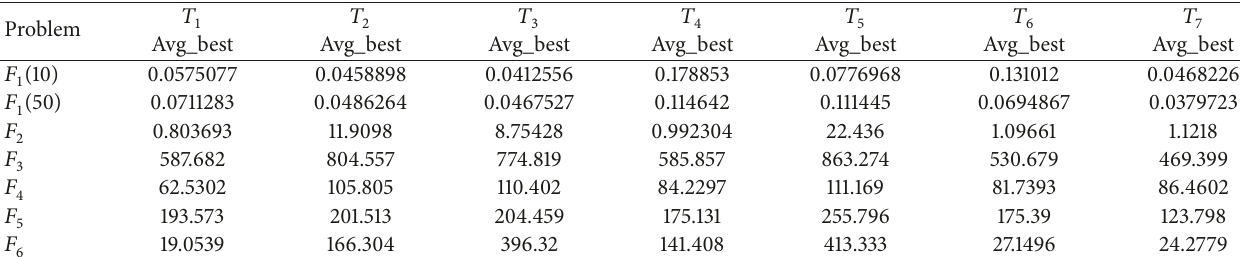
Table 8: Average best error values achieved for problems 𝐹 1 – 𝐹 6 by Basic